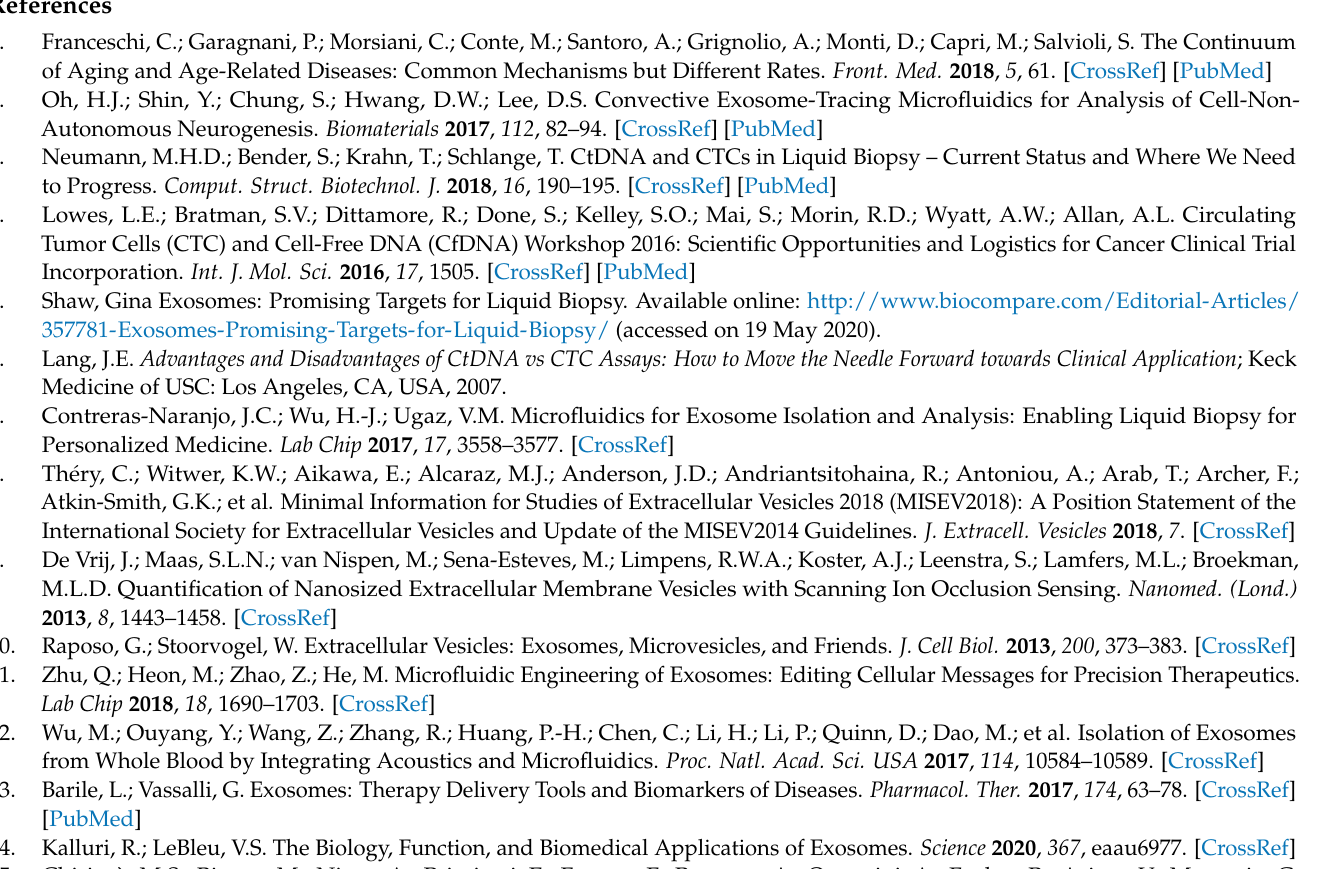
Table S2: Comparative analysis and specifications of microfluidic devices for exosome isolation and